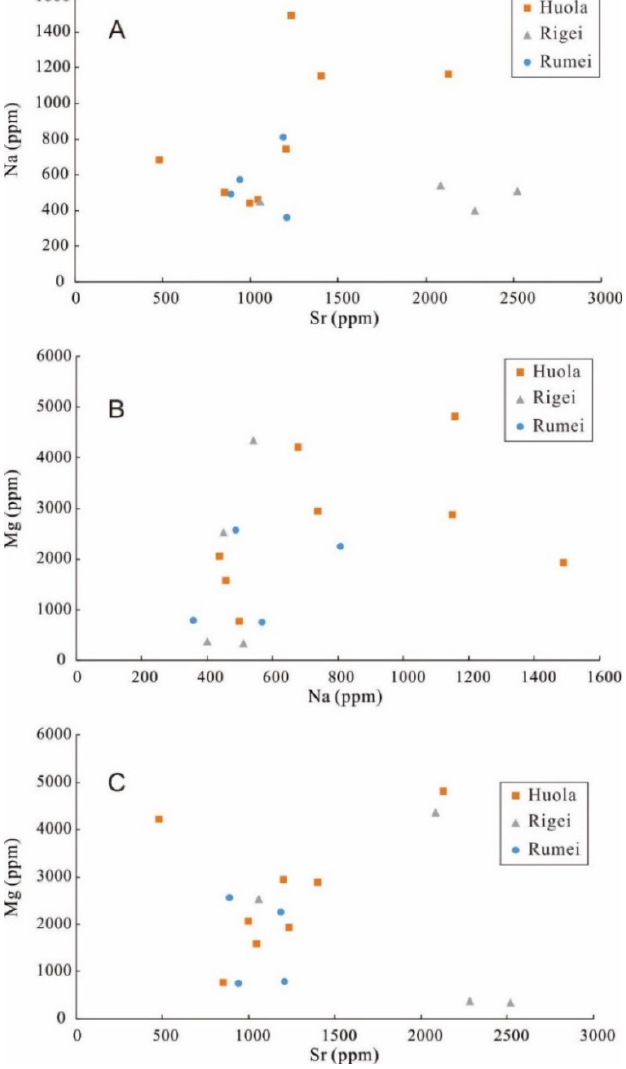
Figure 5. Sr vs. Na ( A ), Na vs. Mg ( B ), and Sr vs. Mg ( C ) of gypsum samples from Huola, Rigei, and Rumei in the Qamdo Basin. Rumei in the Qamdo